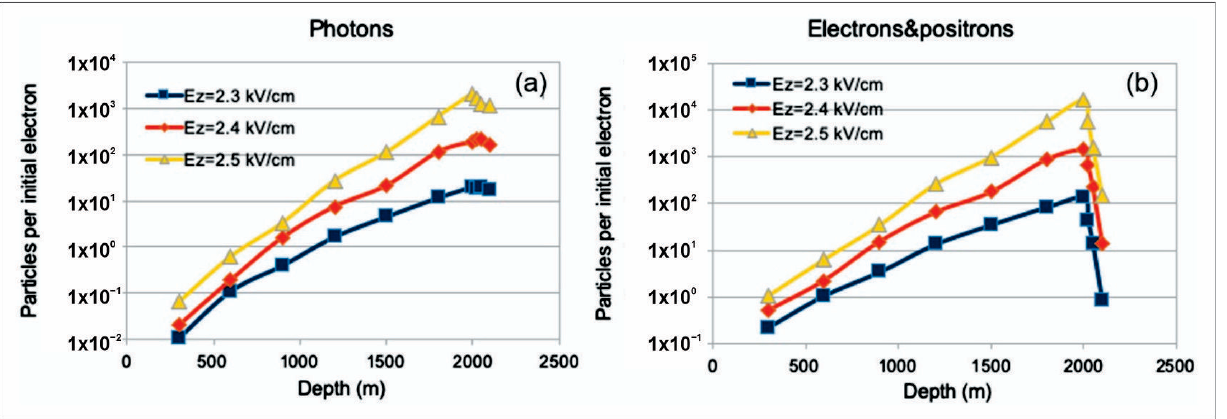
Figure 20. Development of RREAs in the thunderous atmosphere. The avalanche started at an altitude of 4600 m, 2 km above the SEVAN detector at Lomnicky Stit. The number of avalanche particles was calculated every 300 m per seed electron per m 2 . After leaving the electric field, the avalanche particles were tracked for another 100 m.